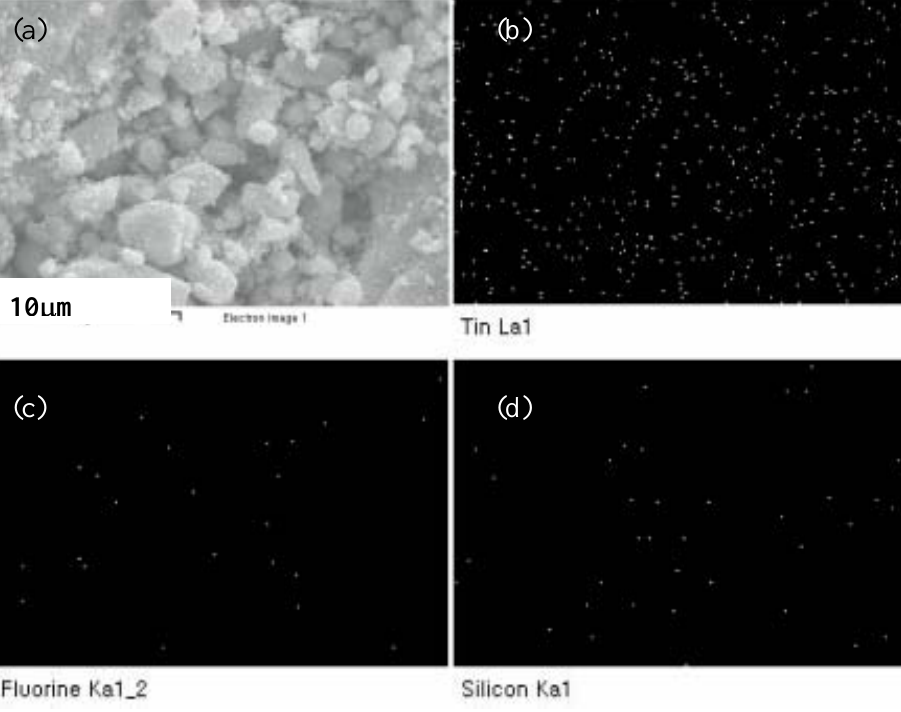
coated F-doped SnO 2